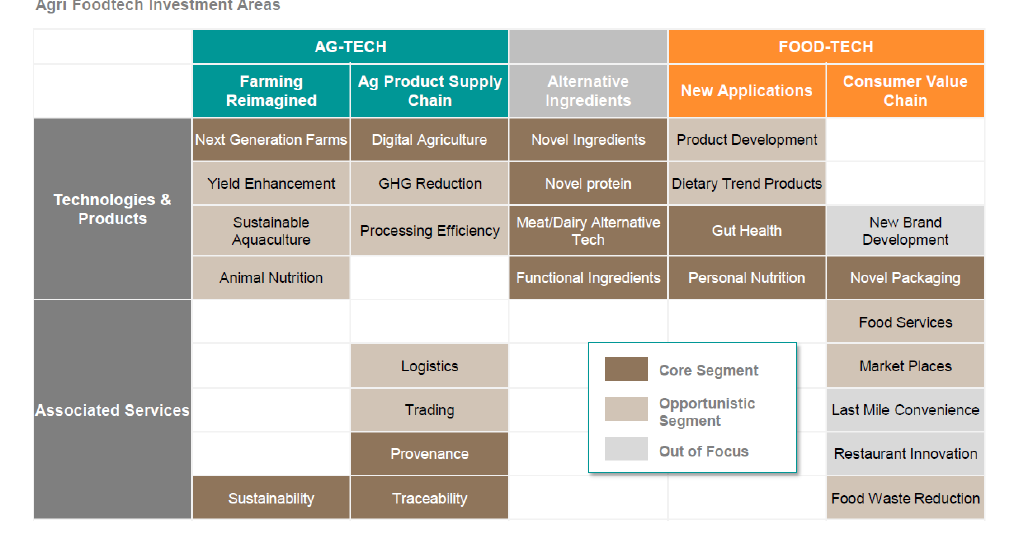
Figure 4: Agri-foodtech Investment